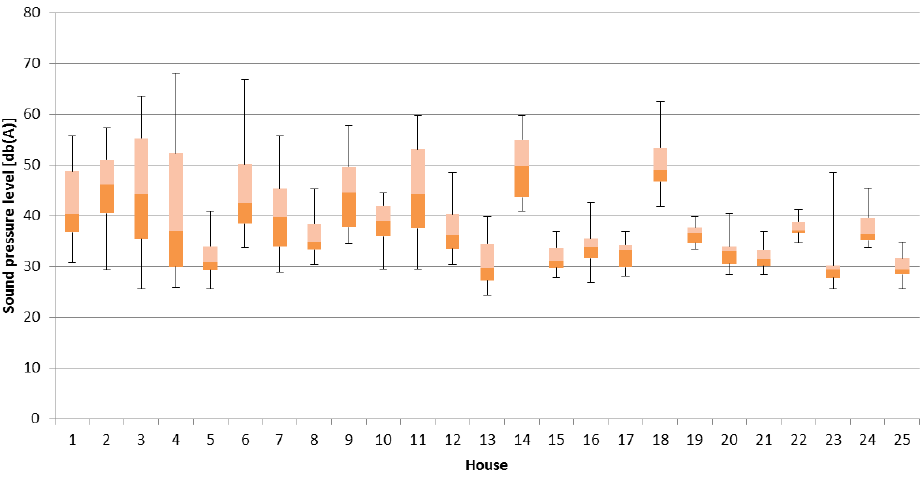
Figure 3. Box plot of sound pressure level.